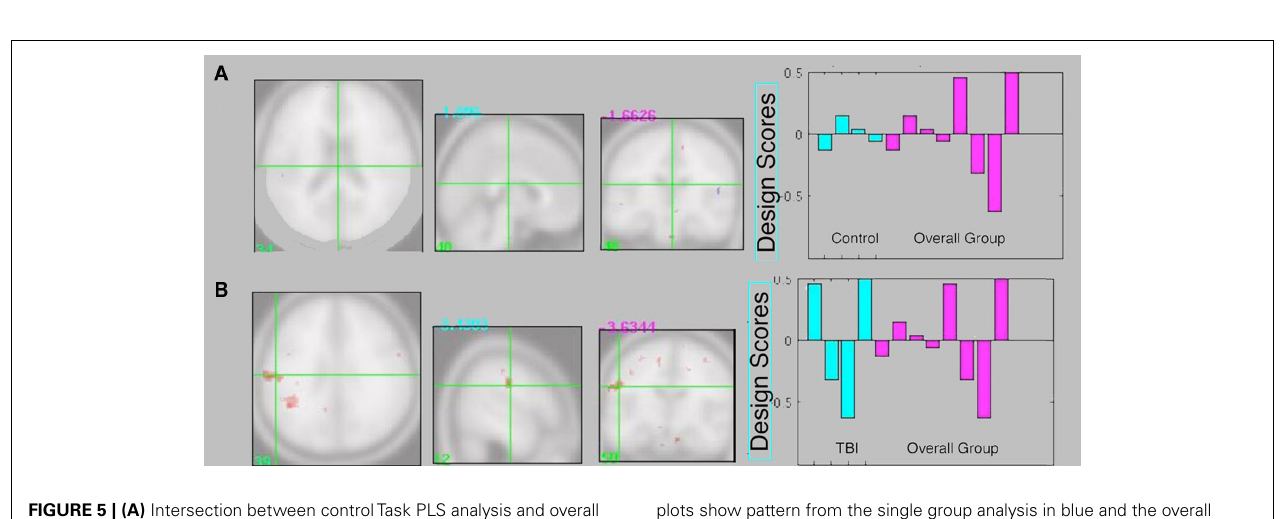
FIGURE 5 | (A) Intersection between controlTask PLS analysis and overall group analysis.There is very little overlap in brain activity patterns. (B) Intersection betweenTBITask PLS analysis and overall group analysis. Several regions show overlapping activity, including two larger clusters in the left inferior parietal lobule, suggesting the brain activity patterns in the overall analysis are primarily being driven by theTBI group. Design score